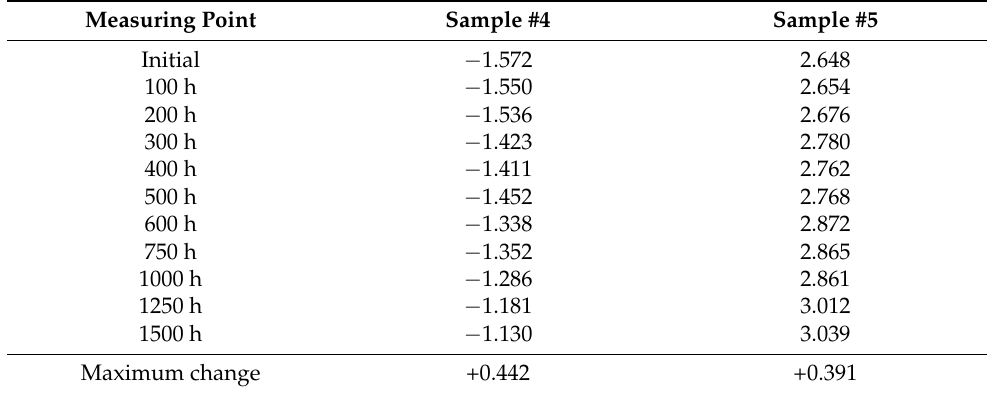
Table 5. Measurement data of high-temperature acceleration experiments (unit: 10 − 3 C 0